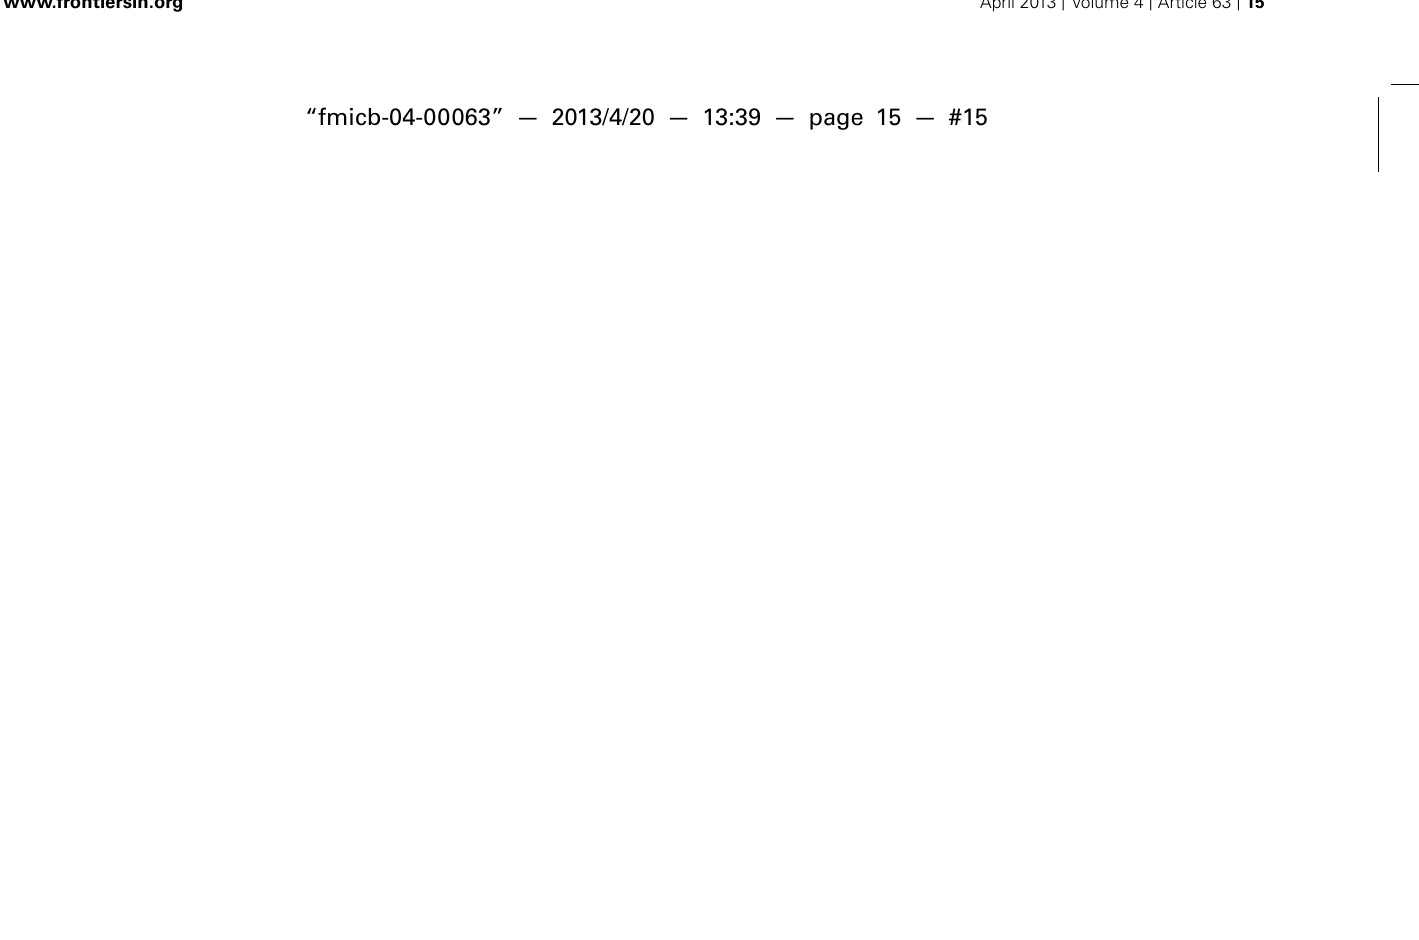
FIGURE 8 | Reaction pathways which are likely to be significant in the BF09-06 sulfur deposit, based on the relative abundance of functional genes. Solid lines indicate oxidative reactions and dotted lines indicate reductive reactions. Blue lines